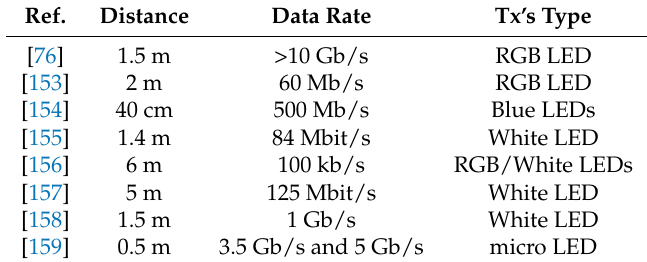
Table 6. Some of the VLC work performed at different